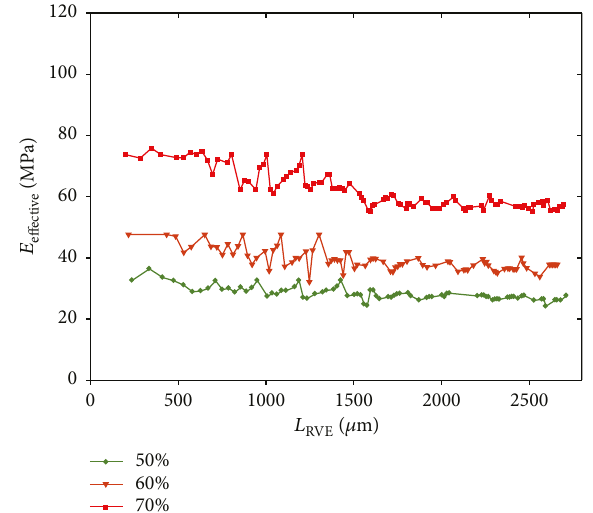
Figure 7: E ff ect of RVE size on e ff ective